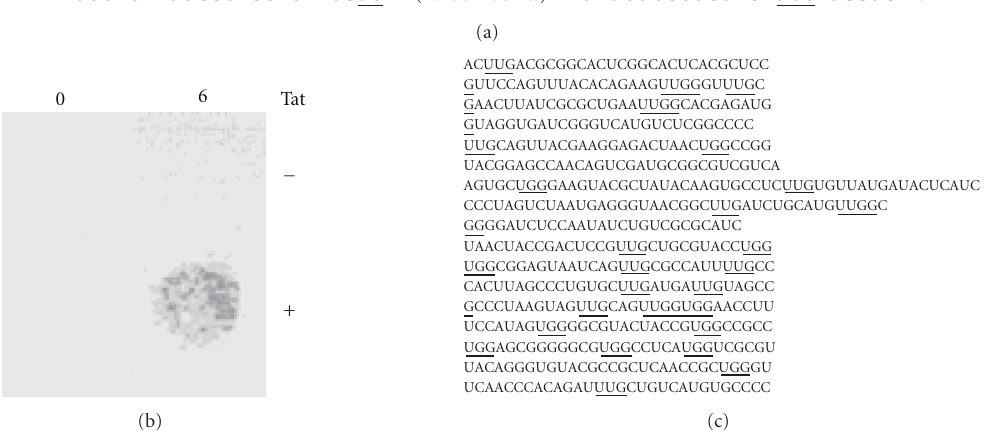
Figure 2: The RNA library used in this study. (a) The primary sequence of the constant region and the location of the 30 random nucleotides within the 78-nuclotide RNAs that compose the library are indicated. (b) Tat-binding ability of the libraries before selection (0) and after six rounds of the selection (6). Dot blot analysis was carried out with 10pmol 32 P-labeled RNA and 2.5 pmol Tat peptide in 50 μ L of the binding bu ff er. (c) Primary sequence of the 30-nucleotide random region from 17 clones of the library after six rounds of the selection. The frequent triplets after the triplet subtraction, UUG and UGG, are underlined.